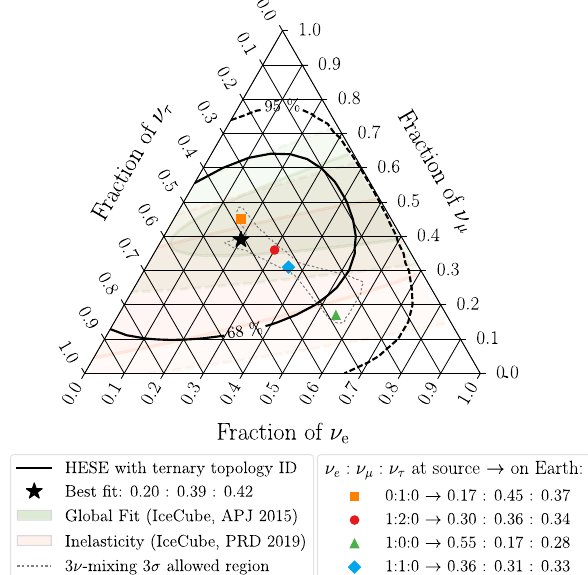
Fig. 6 Measured flavor composition of IceCube HESE events with ternary topology ID and extended multi-dimensional analysis of the double cascades (black). Contours show the 1 σ and 2 σ confidence intervalsassumingWilks’theorem[60]holds.Theshadedregionsshow previously published results [27,61] without direct sensitivity to the tau neutrino component. Flavor compositions at source and after propa- gation expected from various astrophysical neutrino production mech- anisms (see, e.g., [9]) are marked, and the entire accessible range of flavor compositions assuming standard 3-flavor mixing is